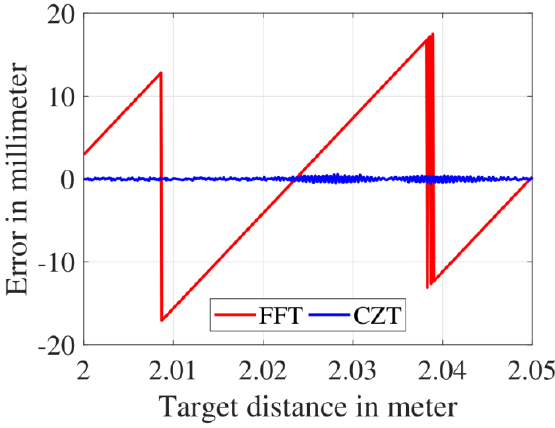
Figure 3. Comparison of the distance measurement error with the FFT and CZT.